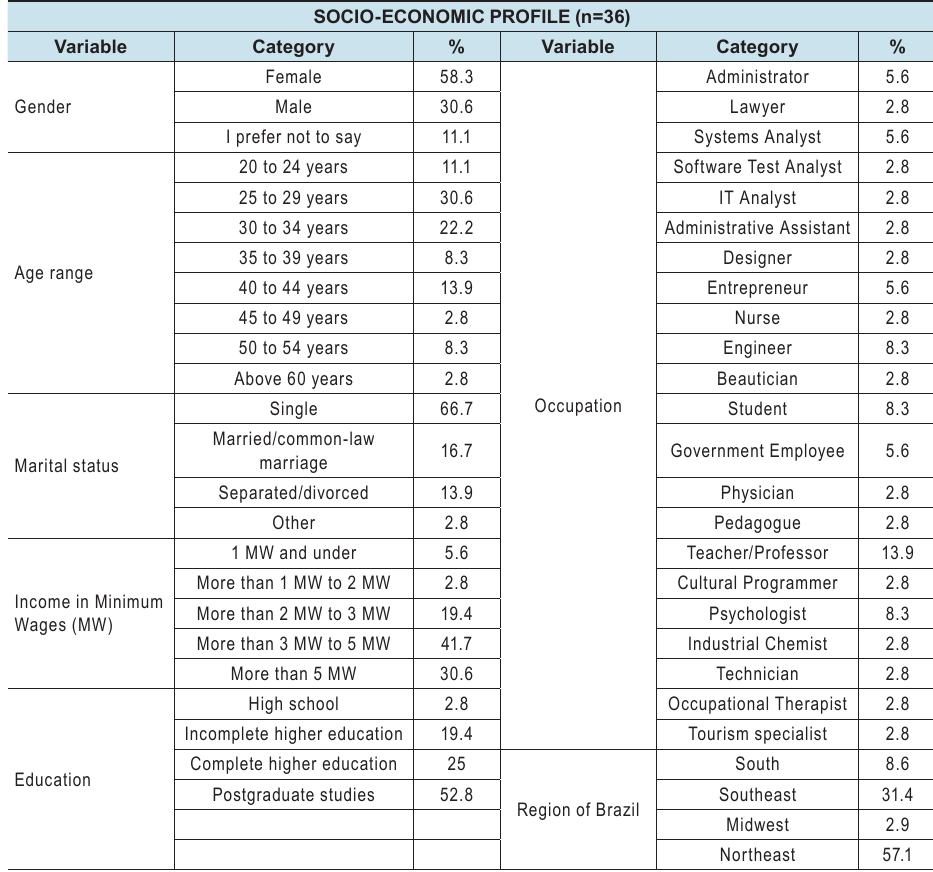
TABLE 5 . Sociodemographic profile of tourists considered to have a strong affinity for the practice of geotourism in the territory of the Serra do Sincorá Geopark Project, Lençóis, Bahia.